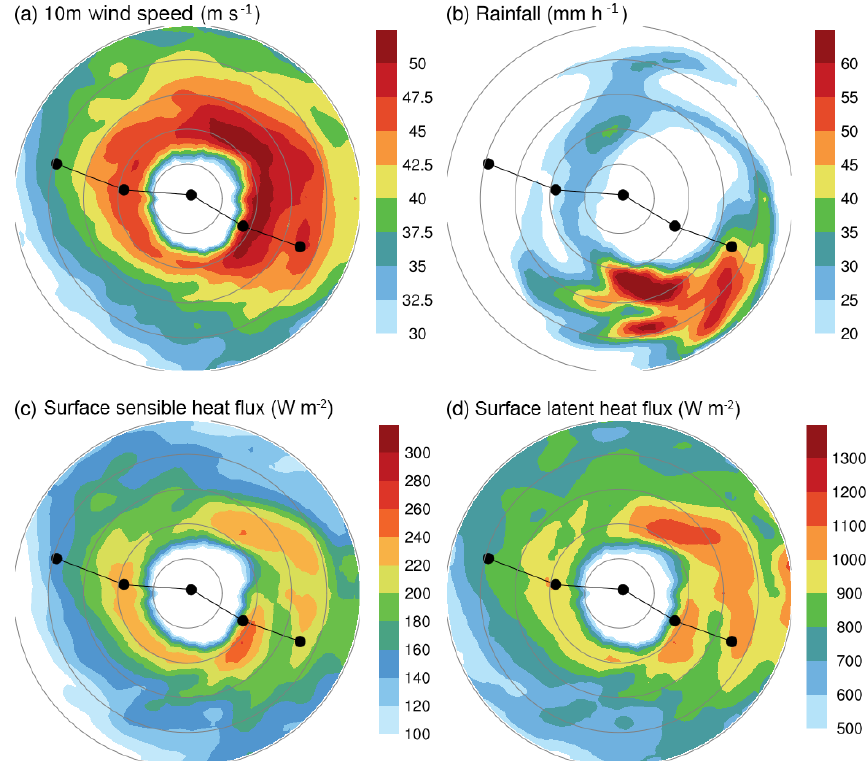
Figure 5. Horizontal distributions for (a) wind speed (ms − 1 ) at 10m height, (b) total rainfall (mmh − 1 ), (c) surface sensible heat flux (Wm − 2 ), and (d) surface latent heat flux (Wm − 2 ) at forecast hour 71h (valid at 22:00UTC on 7 November) for the experiment F0 with 3km resolution. All fields are taken from the transformed subset on cylindrical grids; see text for detail. At 71h, the simulated typhoon centered at the nearest location to the best-track location at 18:00UTC on 7 November 2013. Range rings are shown at radii of 20, 40, 60, 80, and 100km. Black dot at the plane center denotes the simulated typhoon center at 71h, whereas the two dots to the upper left and lower right of this central dot are the corresponding locations of the typhoon center in the next and previous 2h. Solid lines connecting these dots denote the simulated typhoon track within the